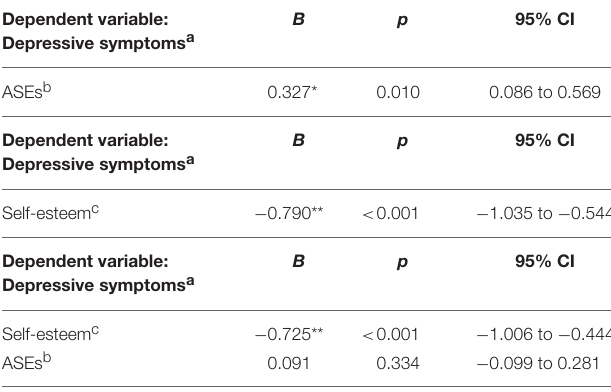
TABLE 4 | Women: Hierarchical regression analysis with depressive symptoms as the dependent variable and ASEs and self-esteem as independent variables, demonstrating mediating effects of self-esteem in